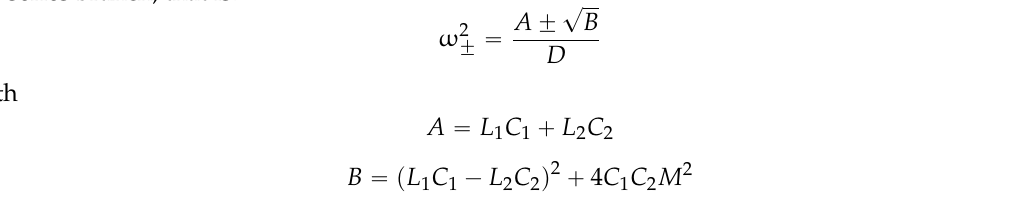
Figure 2. ( a ) Microstrip line section loaded with a pair of SISS; ( b ) lumped element equivalent circuit model.